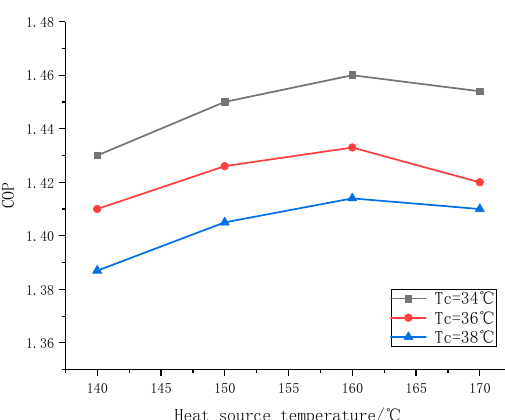
Figure 6. Effect of heat source and cooling water temperatures ( T c ) on system performance.